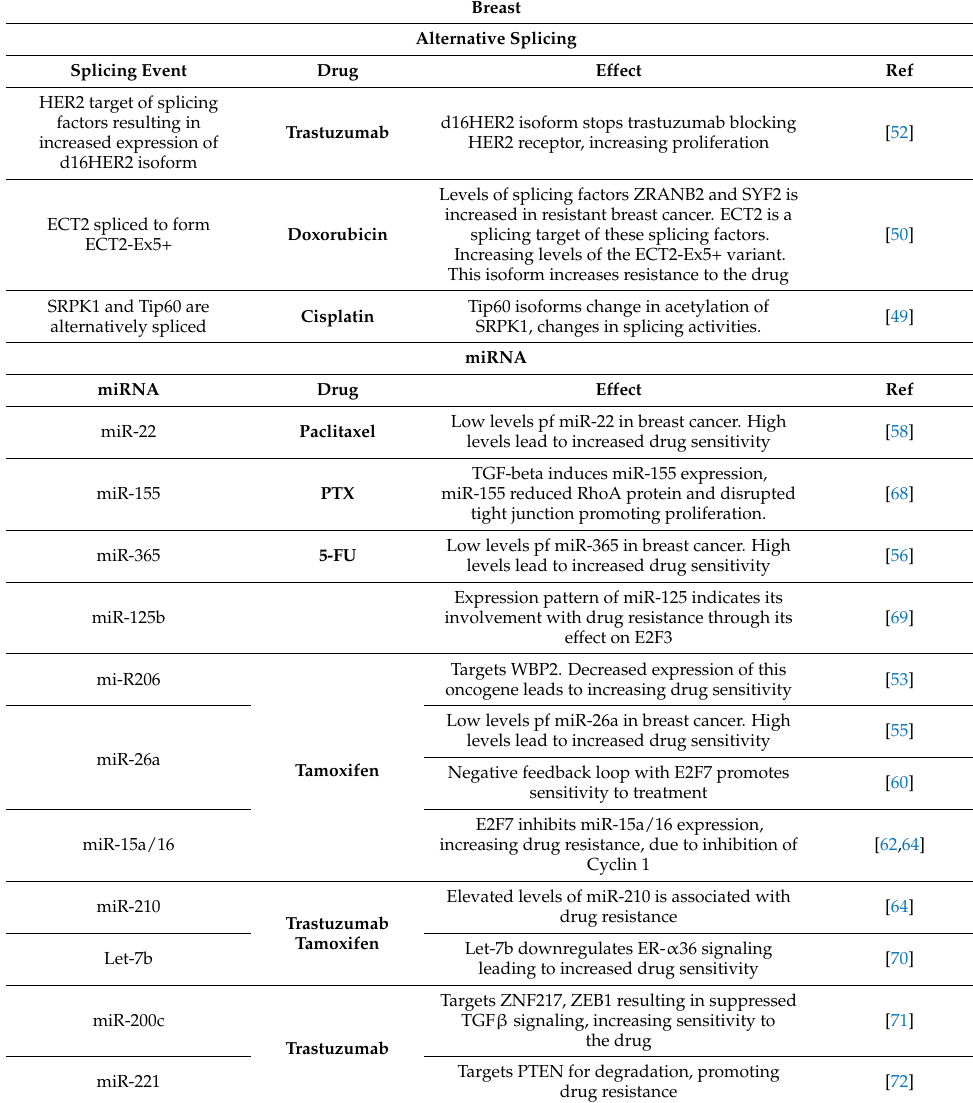
Table 1. Alternative splicing events and miRNAs involved in drug resistance in breast cancer cells.